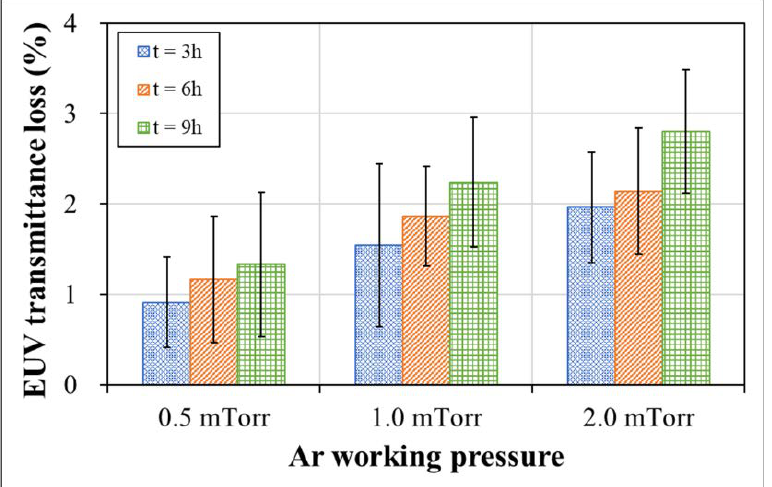
Figure 6. EUV transmittance loss of Ru/SiN x pellicle composite deposited by various working pressures as a function of total laser-pulsed heating time.